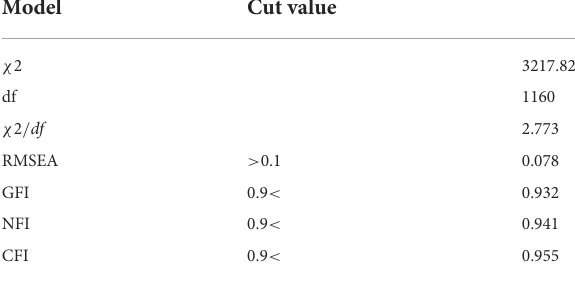
TABLE 4 The results of fit indices (model